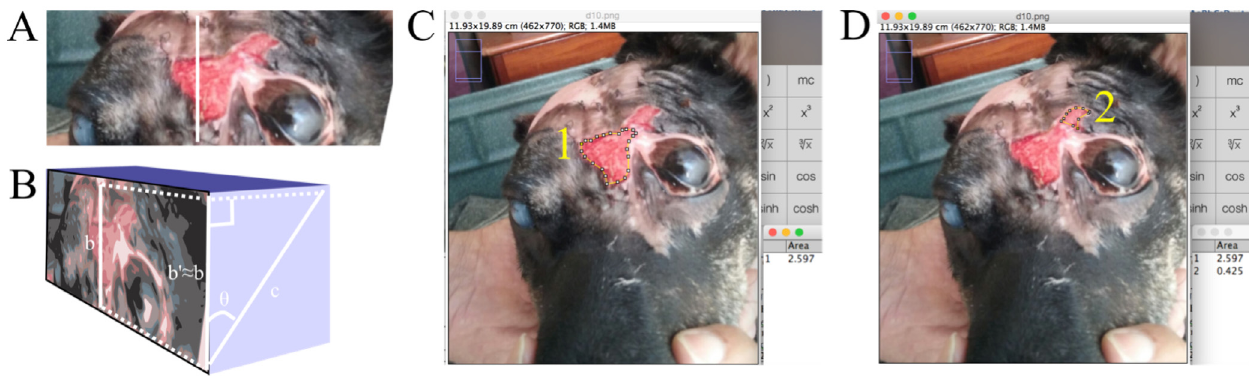
Figure 4. ImageJ software image analysis approach for quantitative size measurement of wounds - Part 2. ( A ) The known distance (b) traced was, for photographs captured at an angle exactly normal to the wound plane, used for the “Set scale” function as-is, to trace the wound margin for use with the “Measure” function to obtain the wound area. ( B ) For photographs captured at an inclined angle, a semi-quantitative estimate of the inclination angle (theta) was made and a simplified trigonometric system used to approximately determine the known distance’s (c) adjacent cathetus b’ (b’ ≈ b; the unknown distance in the camera plane) measurement in the observer (camera) plane . Then, using “Set scale”, the distance traced in b was taken as equal to b’=c*cos( θ ). ( C and D ) Thereafter, the wound margins were traced using the “Polygon selection” tool for subsequent measurement. This patient’s wound at this time point had formed a “pinch point” whereby the wound area above the eye had become discontinuous with the wound area adjacent to the eye (originally, these two were continuous) due to the advancing epithelialization, thus forming two distinct wound areas, 1 and 2, that were measured (using “Analyze-Measure”) as shown in C and D , respectively, and the sum of this observer (camera) plane wound area projected onto the true inclined wound plane using the trigonometric system explained above. The total wound area (whether a single area or the sum of distinct areas) was calculated and